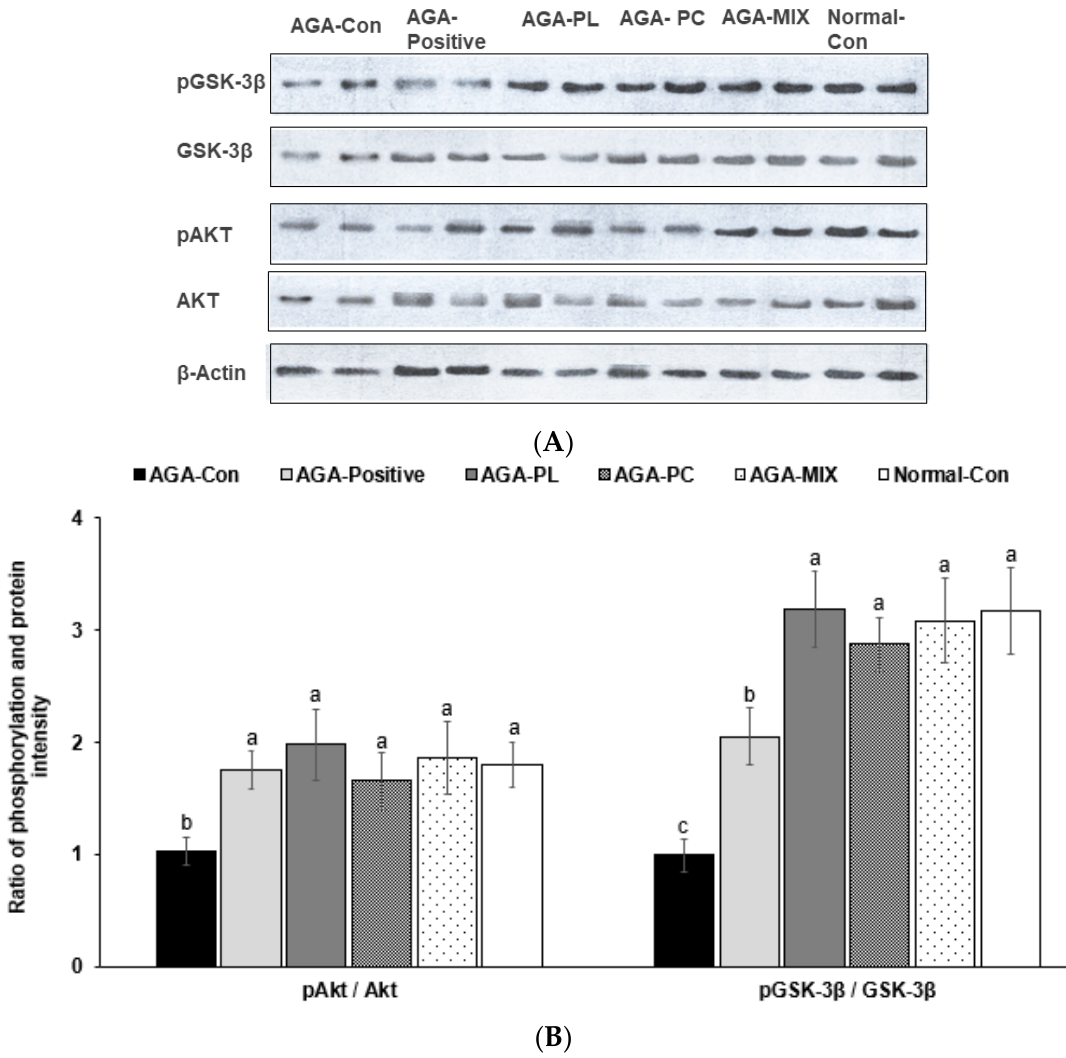
Figure 6. Phosphorylation of Akt and GSK-3 β in the dorsal skin. ( A ) The phosphorylation and protein contents of Akt and glycogen-synthase kinase-3 β (GSK-3 β ). ( B ) The ratio of the phosphorylation and protein of Akt and GSK-3 β . Bars and error bars are mean ± standard deviations (N = 4). a,b,c Different letters on the bars indicate a significant difference as per a Tukey test at p < 0.05, and no or the same letters indicate no significance between the groups. The insulin signaling pathways were measured with western blotting analysis, and an image analyzer measured their intensity. AGA was induced with the application of 0.5% testosterone propionate solution on the back of mice, and AGA-induced mice orally consumed 0.1% PL, 0.1% PC, or 0.1% mixture of PL and PC (1:1, w / w ) in a 43% fat diet (HFD), called AGA-PL, AGA-PC, or AGA-MIX groups, respectively. AGA-induced mice were daily applied with 2% finasteride on the back, as AGA-Positive (positive control). AGA-Positive and AGA-Con (control) mice had 0.1% cellulose (no effective activity in AGA treatment) in an HFD. Normal-Con did not induce AGA and consumed 0.1% cellulose in an HFD. All mice had an 8-week